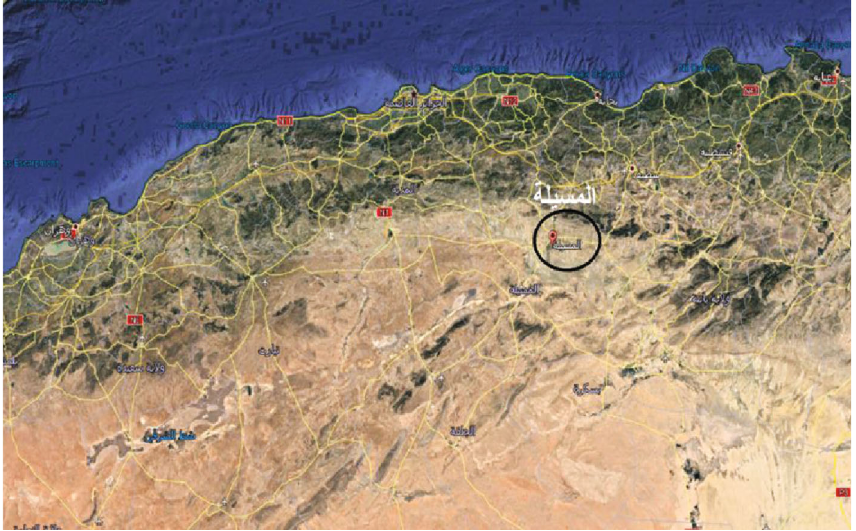
Figure 4: Map of the region of “ M ’ sila. ” Table 1: Monthly average of irradiation in M ’ sila.